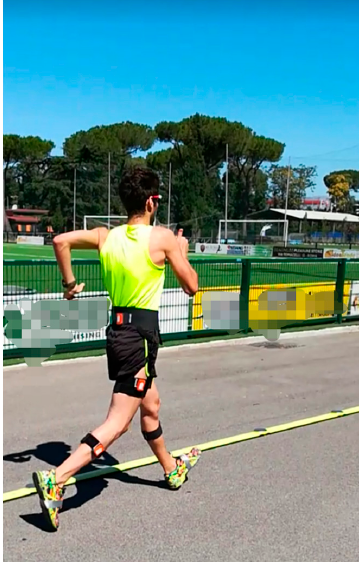
Figure 5. Placement of IMUs (orange probes) on an athlete during the experimental procedure.